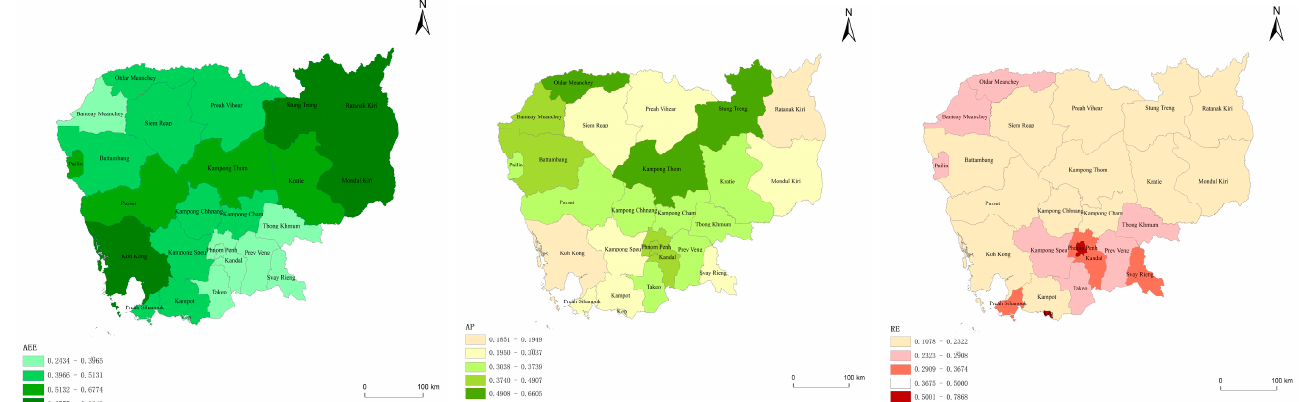
Figure 3. Spatial pattern of the agricultural production, road construction and agricultural eco- environment in Cambodia.